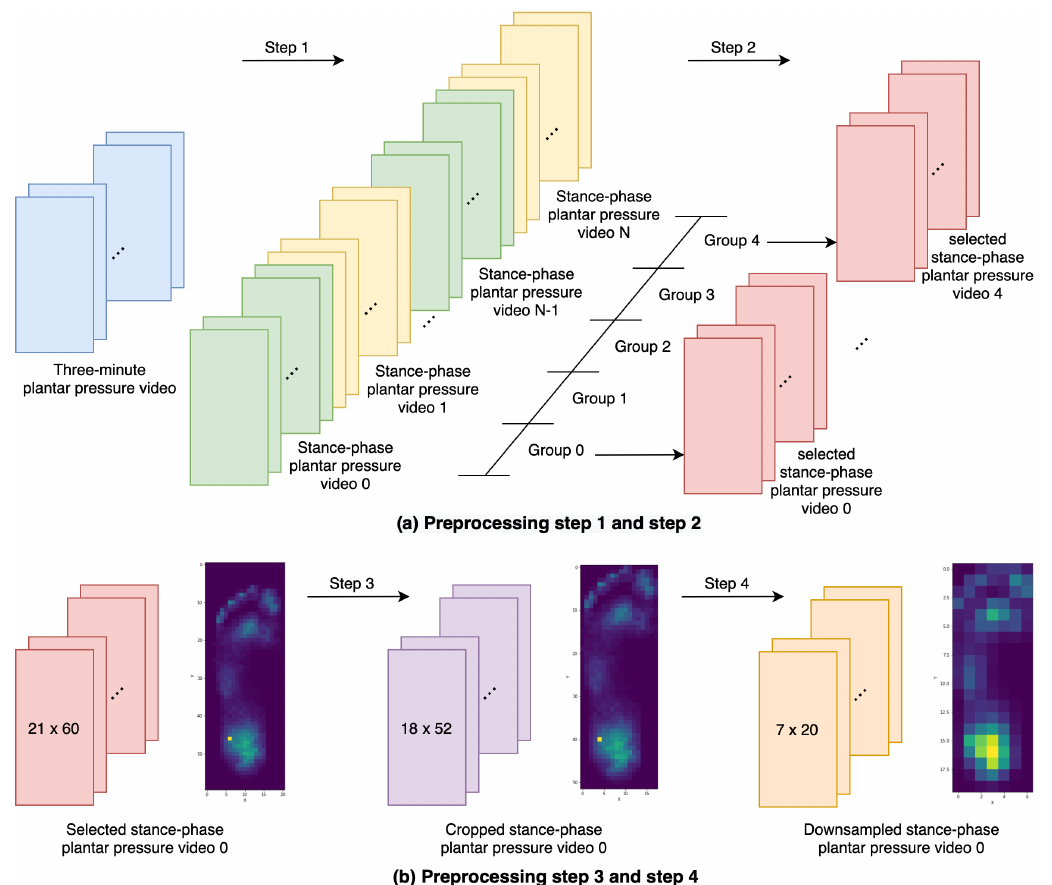
Figure 2. Illustration of preprocessing steps. ( a ) The green and yellow videos represent the stance-phase plantar pressure video; each video’s total frame count depends on its stance-phase duration. The pink videos represent the stance-phase plantar pressure video that randomly selected from five equal groups. ( b ) In step three and step four, we use one of the chosen videos for a demonstration; the image beside each video is its pixel-wise accumulated image, which utilizes to visual the cropping and resampling processes. The purple video represents the cropped video, and the orange video is the final result, which has a 7 × 20 spatial